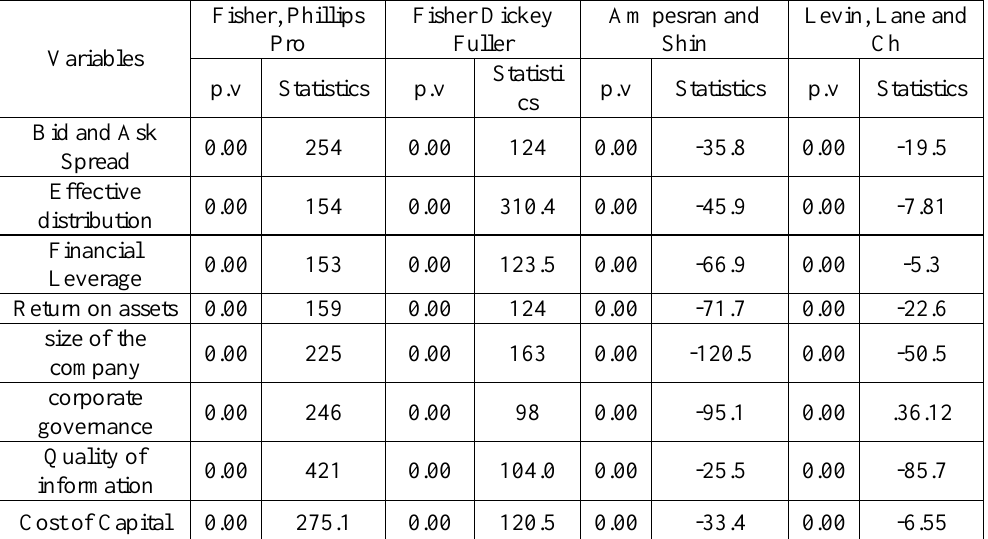
Table 3. Results of the reliability test of variables